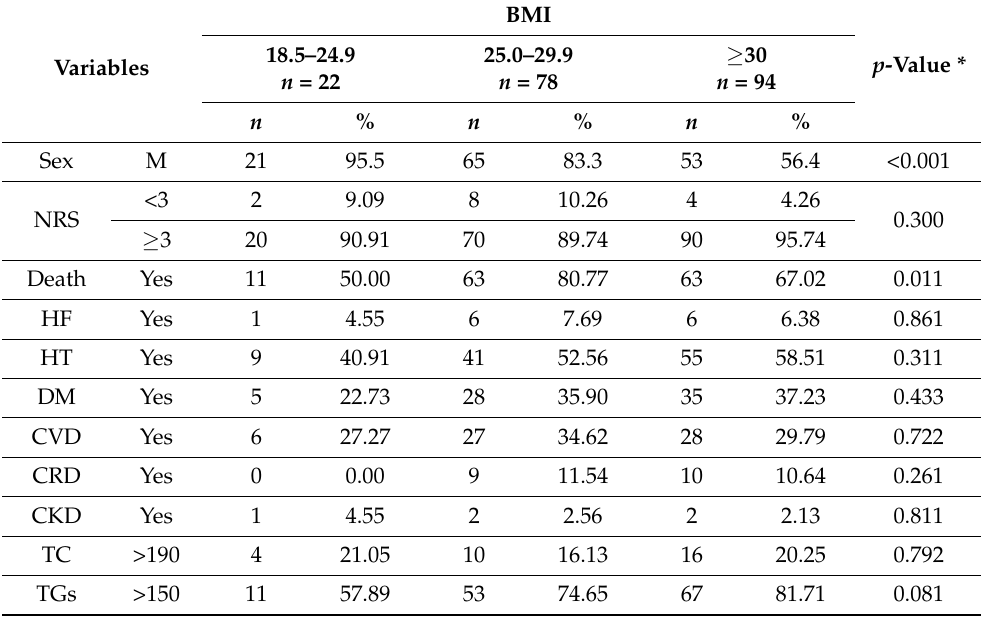
Table 2. Comparison of assessed parameters (qualitative variables) and BMI range (WHO criteria) values.